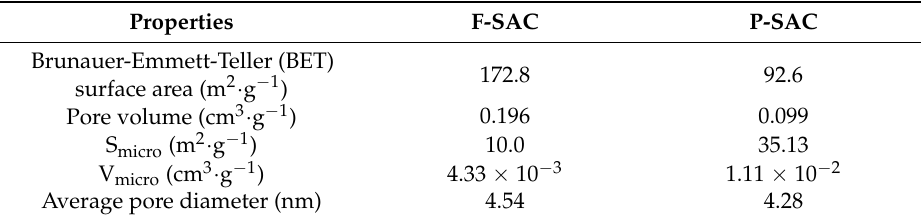
Figure 5. Scanning electron microscope (SEM) images of ( a ) F-SAC and ( b ) P-SAC. Table 2. Properties of the